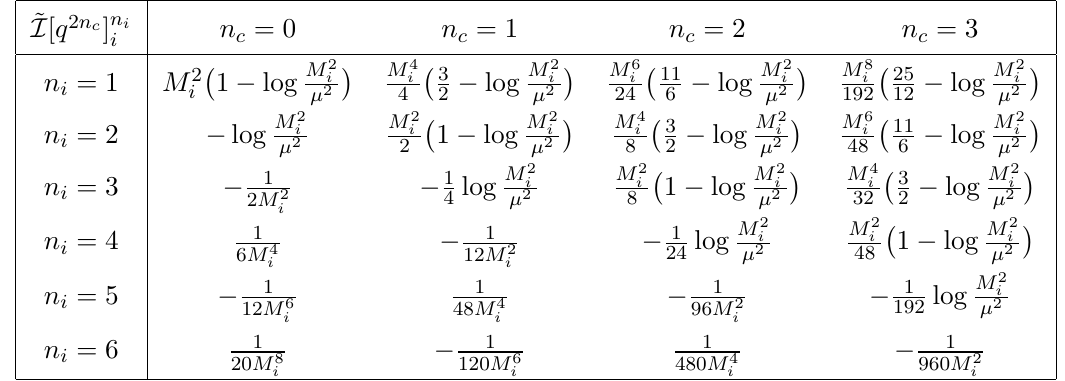
(cid:17) I [ q 2 n c ] n i = i , with 2 = 2 (cid:0) (cid:13) + i i 16 (cid:25) 2 (cid:22) (cid:15) (cid:15)